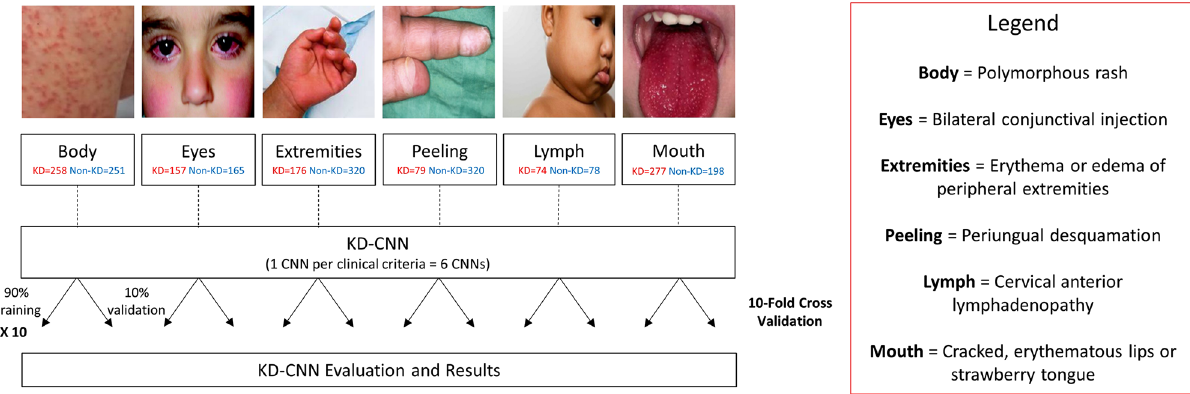
Figure 1. Dataset selection and KD-CNN development diagram. Example images and total number of samples per class, labeled as “KD” and “Non-KD,” are shown for each clinical